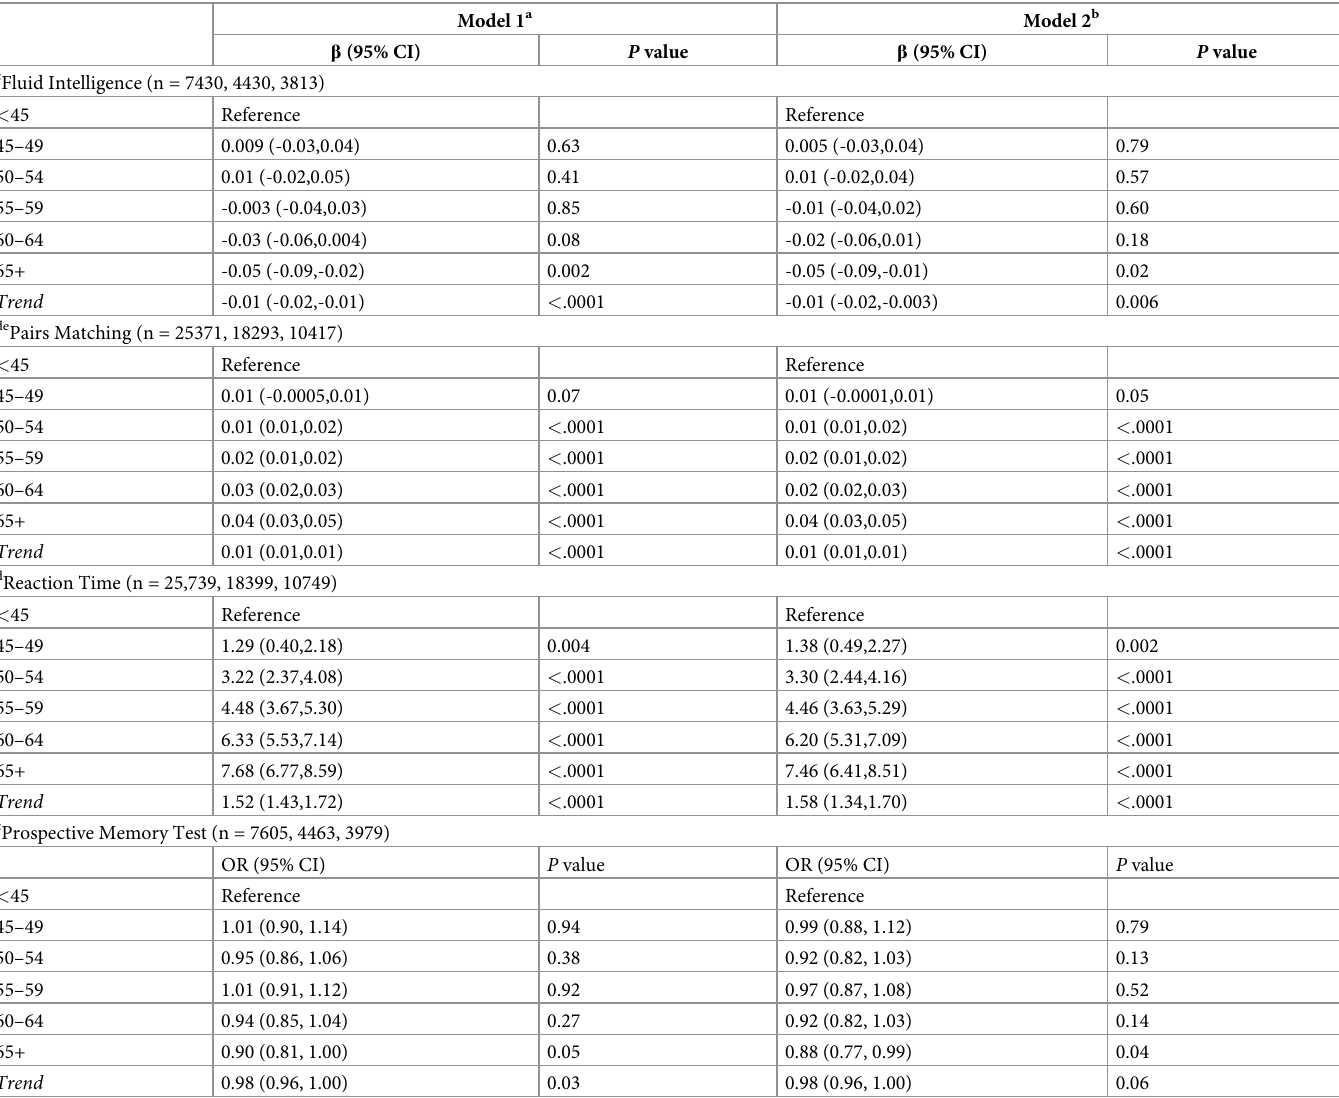
Table 3. Longitudinal analysis of age and cognitive